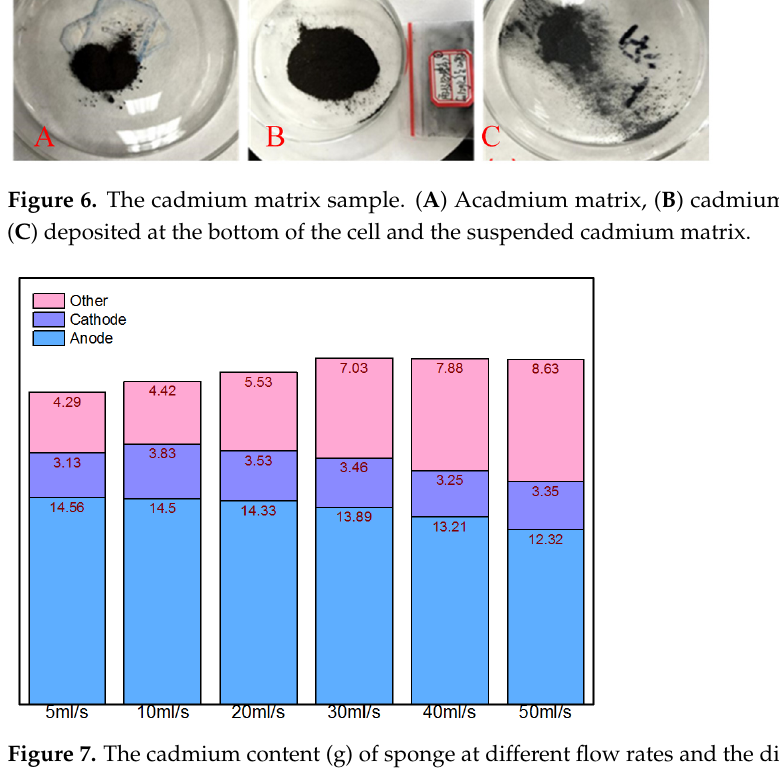
Figure 8. The current efficiency of cadmium sponge obtained at different flow